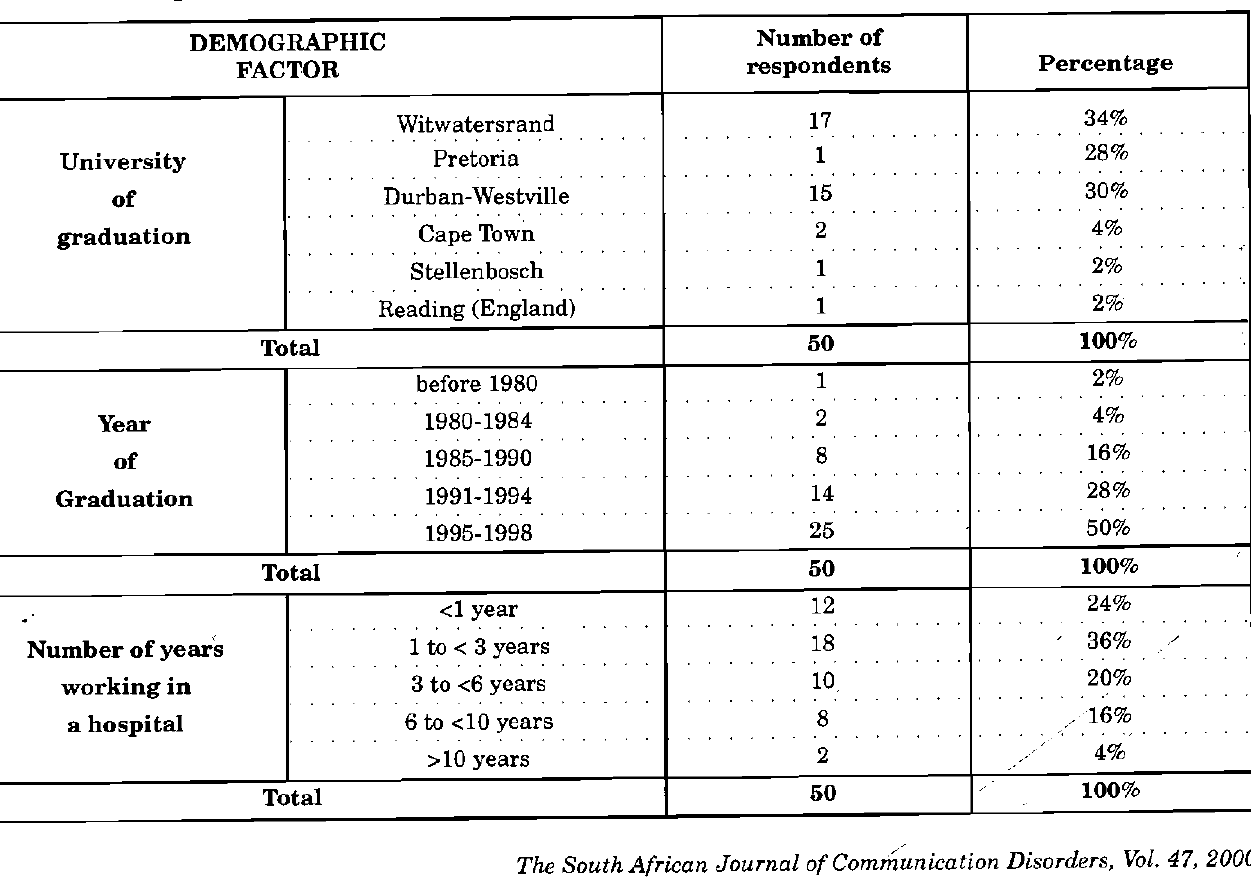
TABLE 1: Description of the subjects